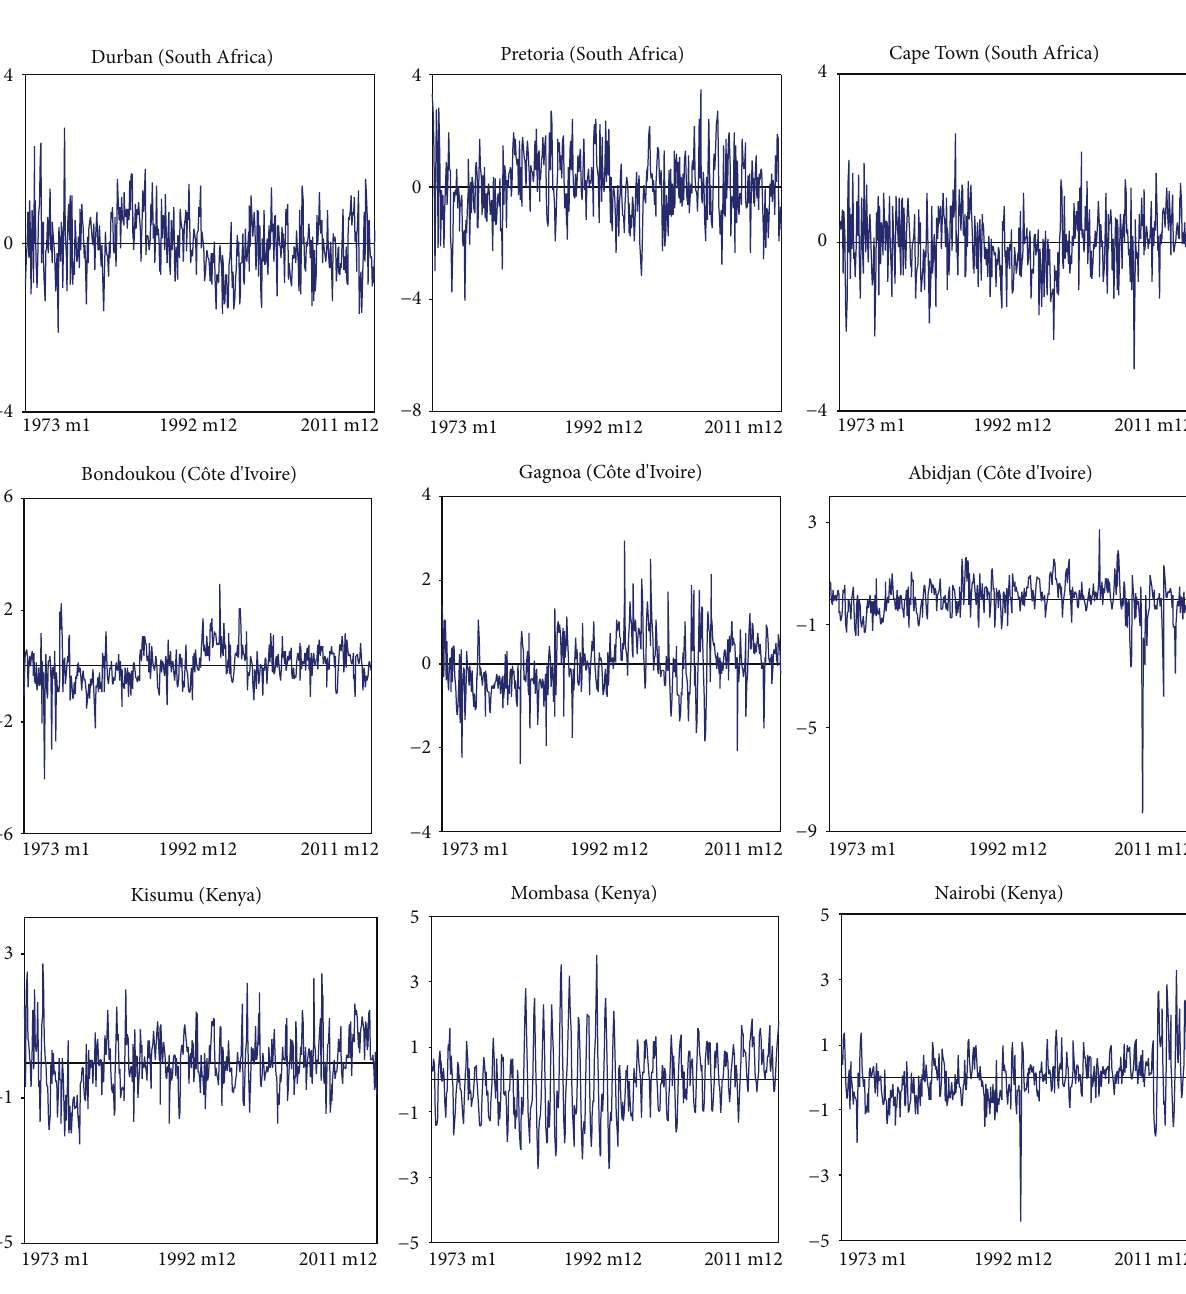
Figure 2: Seasonal anomaly